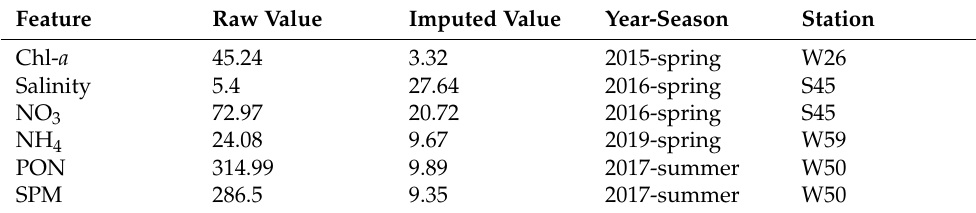
Table 4. Forced missing data. Abbreviations: PON, particulate organic nitrogen; SPM, suspended particulate matter; Chl- a , chlorophyll- a